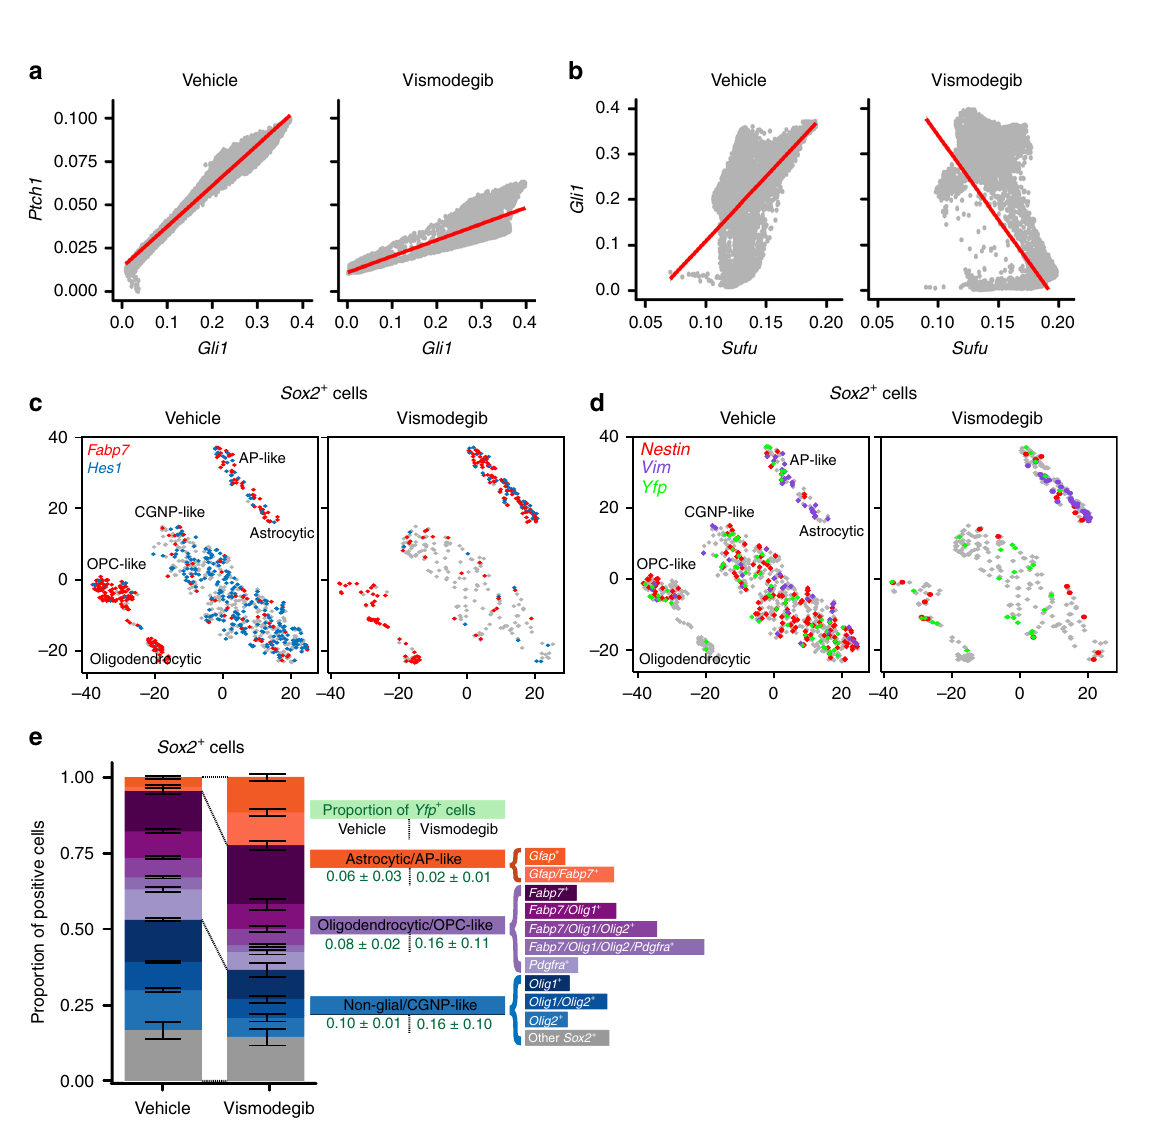
Fig. 7 HES1 and MYOD1 mark vismodegib-responsive and resistant subsets of cells. a t-SNE projections as in Fig. 6a, with Gli1 + cells indicated. b MALDESI images of cholesterol and vismodegib distribution in sagittal brain sections including both tumor and normal brain. c t-SNE projections as in a with Hes1 + cells indicated. d IHC for HES1 and pRB in sagittal hindbrain sections from representative M-Smo mice treated as indicated. e t-SNE projections as in a , with Myod1 + cells indicated. f IHC for MYOD1 and pRB in sagittal hindbrain sections from representative M-Smo mice treated as indicated. g Quanti fi cation of data from c – f . Dots represent individual replicate mice. Horizontal lines represent means and error bars indicate SEM. h Analysis of MYOD1, pRB and cell cycle phase by fl ow cytometry. Graphs formatted as in g . i , j Expression microarray data on HES1 and MYOD1 expression in human medulloblastoma samples, as presented in ref. 44 , with boxes indicating the mean, 25th and 75th percentile and whiskers indicating the 10th and 90th percentiles. Scale bars = 2 mm, except in insets where scale bars = 100 µ m. p Values determined by two-sided Student ’ s t -test.